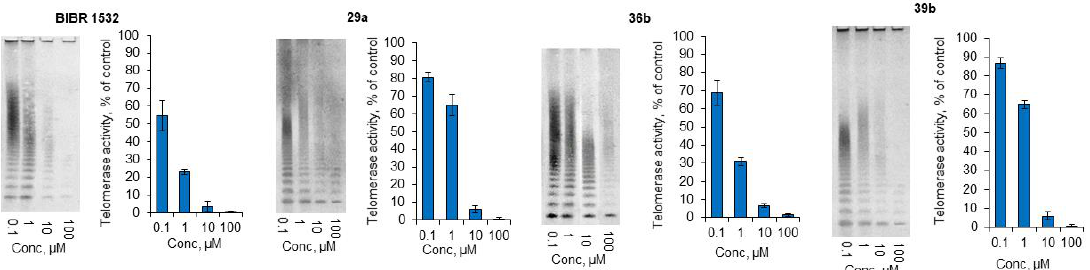
Figure 5. Suppression of telomerase activity in A549 cell-free lysates treated with several concentra- Figure 5. Suppr е ssion of t е lom е r а s е а ctivity in А 549 c е ll-fr ее lys а t е s tr еа t е d with s е v е r а l tions of inhibitors 29a , 36b , and 39b . Representative telomeric repeat amplification protocol (TRAP) gel electrophoresis for treated lysates and quantification of TRAP. For each of the experiments, one representative TRAP gel out of a total of four is presented. The mean ± SEM is used to present the results.